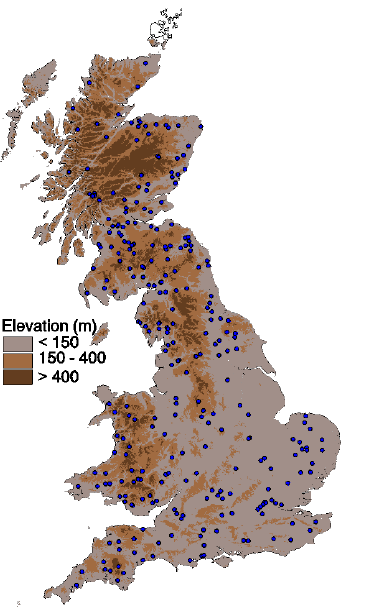
Figure 1. Catchment river outlets where Future Flows Hydrology time series are generated. © Copyright NERC (CEH) 2012. Contains Ordnance Survey data © Crown Copyright and Database Right.